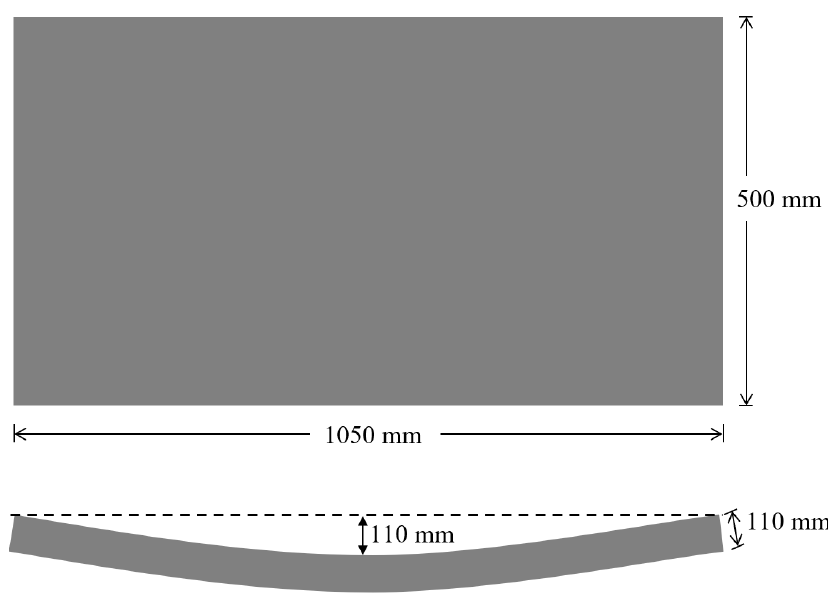
Figure 3. Dimensions of tested UHPC tunnel lining segments.